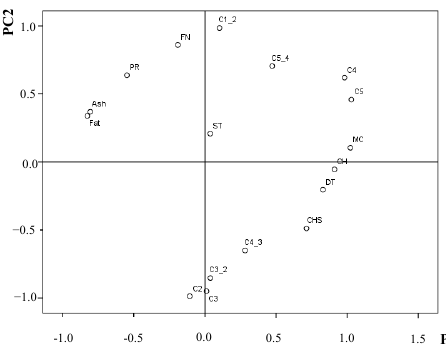
Figure 5. Loading plot of the first two principal components based on physicochemical and rheological properties of the wheat–flaxseed composite flours samples: MC: moisture content; Fat: fat content; PR: protein content; Ash: ash content; CHS: carbohydrates content; WA: water absorption; DT: development time; ST: stability; C2, C3, C4, and C5—Mixolab torques, C1-2, C3-2, C4-3, and C5-4 difference between Mixolab peak values C1 and C2, C3 and C2, C4 and C3 and C5 and C4.